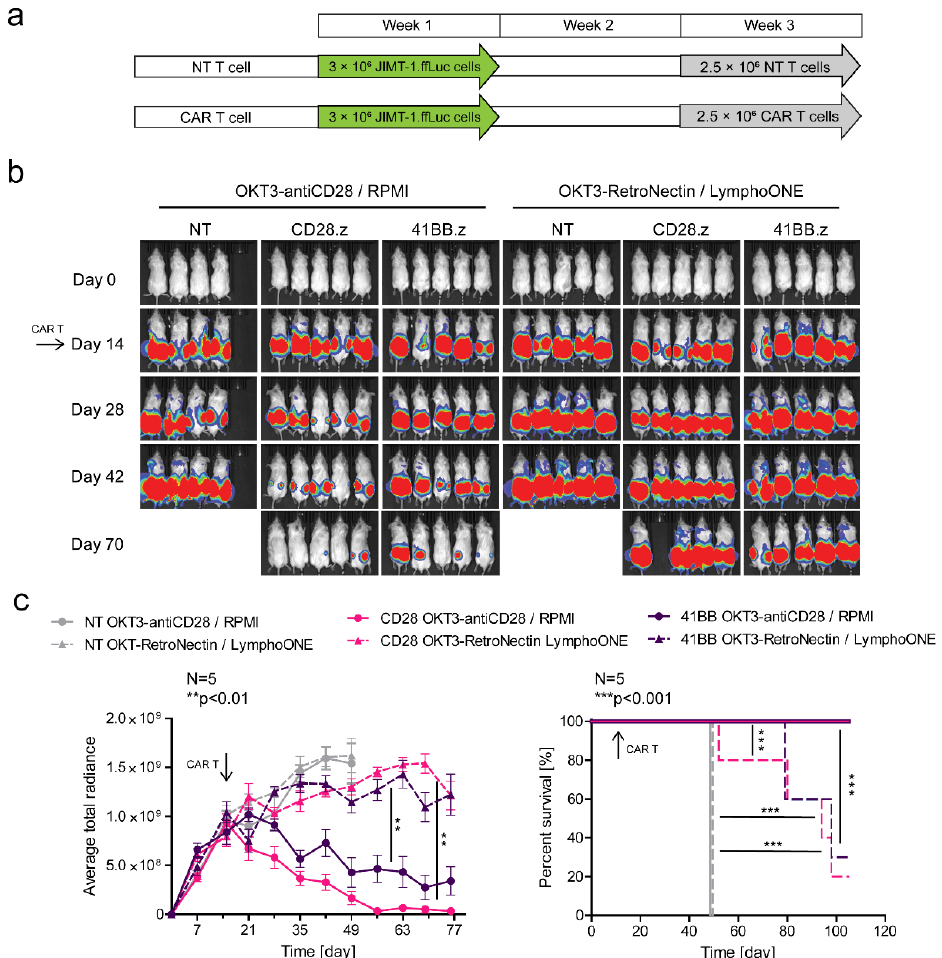
Figure 5. EM-enriched but not CM-enriched HER2-CAR T cells eliminate HER2-positive tumor xenografts in vivo. Mice were injected s.c. with 3 × 10 6 JIMT-1.ffLuc cells. Mice on day 14 (arrow) received a single i.v. dose of 2.5 × 10 6 NT T cells (NT OKT3-antiCD28/RPMI T cells, n = 4, grey, straight line; NT OKT3-RetroNectin/LymphoONE T cells, n = 5, grey, dashed line) or HER2-CAR T cells (CD28.z OKT3-antiCD28/RPMI T cells, n = 5, pink, straight line; CD28.z OKT3-RetroNectin/LymphoONE T cells, n = 5, pink, dashed line; 41BB.z OKT3-antiCD28/RPMI T cells, n = 5, purple, straight line; 41BB.z OKT3-RetroNectin/LymphoONE T cells, n = 5, purple, dashed line). Tumor growth was followed by bioluminescence imaging. ( a ) Outline of the treatment schedule. ( b ) Representative images of JIMT-1.ffLuc-injected animals. ( c , left panel) Quantitative bioluminescence imaging data of JIMT-1.ffLuc xenografts (average total radiance = photons/s/cm2/sr; OKT3-antiCD28/RPMI HER2-CAR vs. OKT3-RetroNectin/LymphoONE HER2-CAR treatment: ** p < 0.01). ( c , right panel) Kaplan–Meier survival curve ( OKT3-antiCD28/RPMI HER2-CAR vs. OKT3-RetroNectin/LymphoONE HER2-CAR treatment: *** p < 0.001; OKT3-RetroNectin/LymphoONE NT vs. OKT3-RetroNectin/LymphoONE HER2-CAR treatment: *** p < 0.001). Histograms represent mean ± SD.